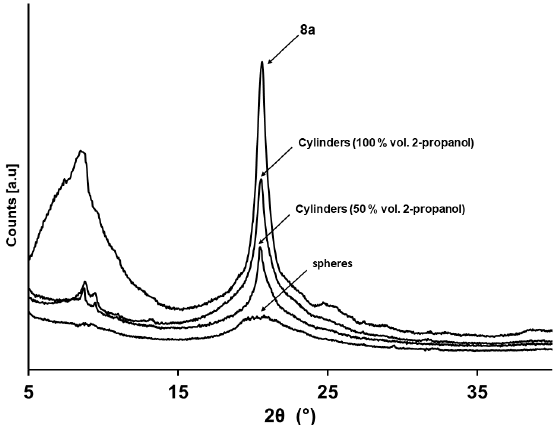
Figure 6. WAXS (wide-angle X-Ray scattering) di ff ractograms for bulk samples of BCP 8a , cylindrical micelles from 8a at 50 and 100% vol. of 2-propanol added, and spherical micelles resulted from the quick addition (one-step) of 100% vol. of